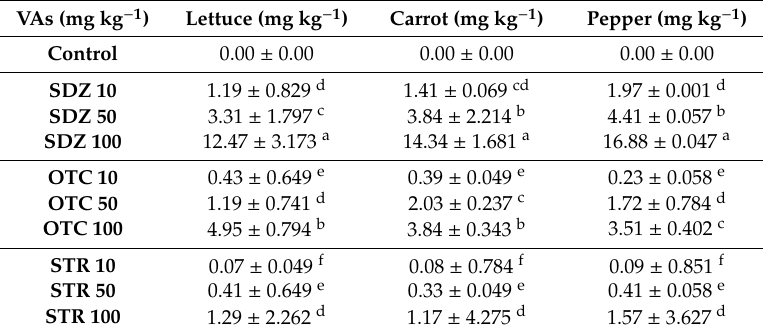
Table 4. Concentration of veterinary antibiotics extracted from the soil planted with lettuce, carrot, and pepper plants at the end of the experimental